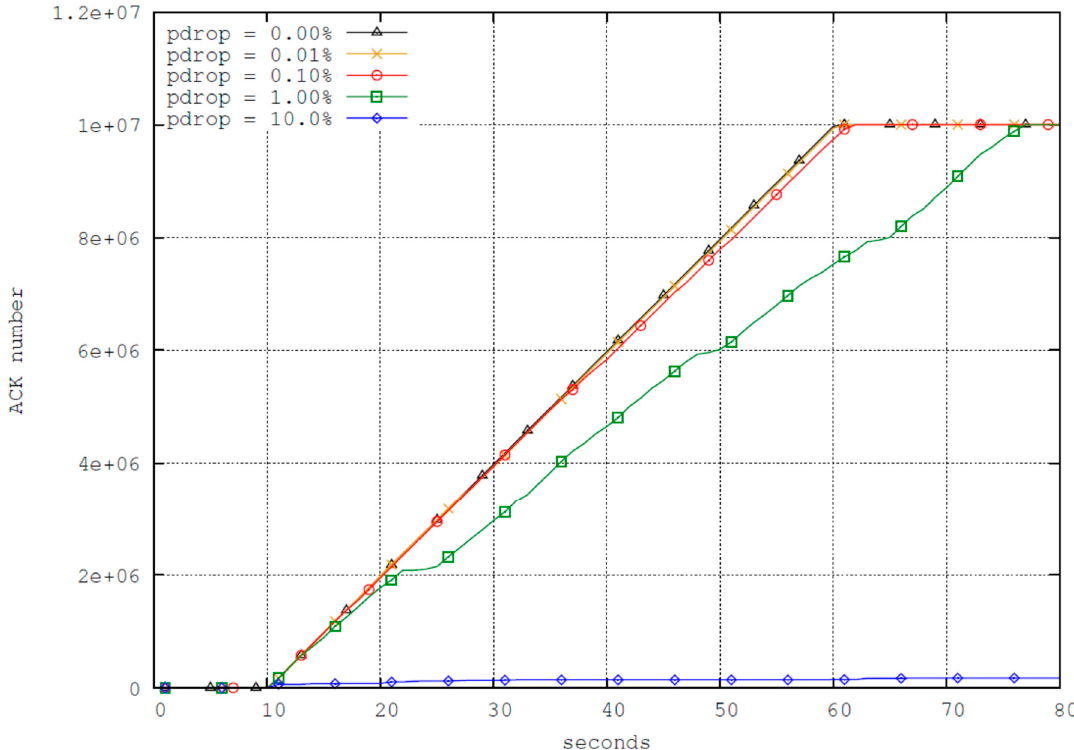
Figure 5. Figure 4 is redrawn for the first 80 s of simulation time.